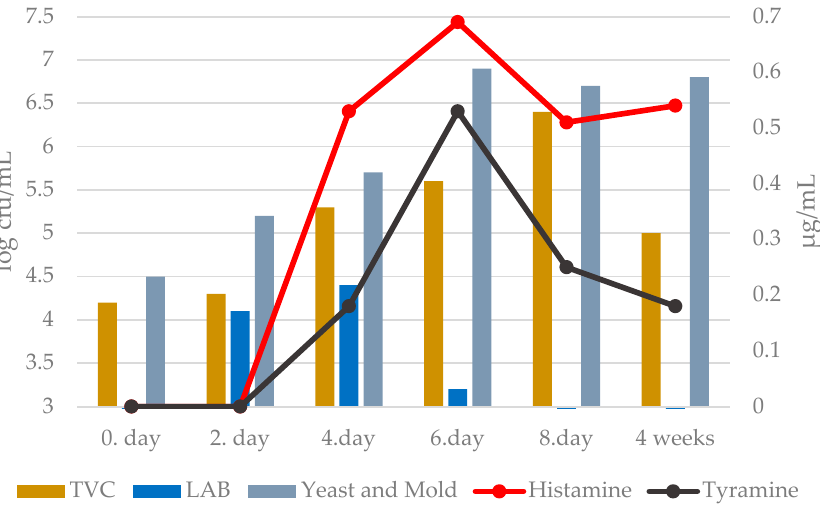
Figure 2. Quantitative microbiological culture examination in relation to the concentration of biogenic amines of must and young wine. TVC—total viable count (sd: ± 0.1); LAB—count of lactic acid bacteria (sd: ± 0.0); Yeast and Mold—count of yeasts and molds (sd: ± 0.1).